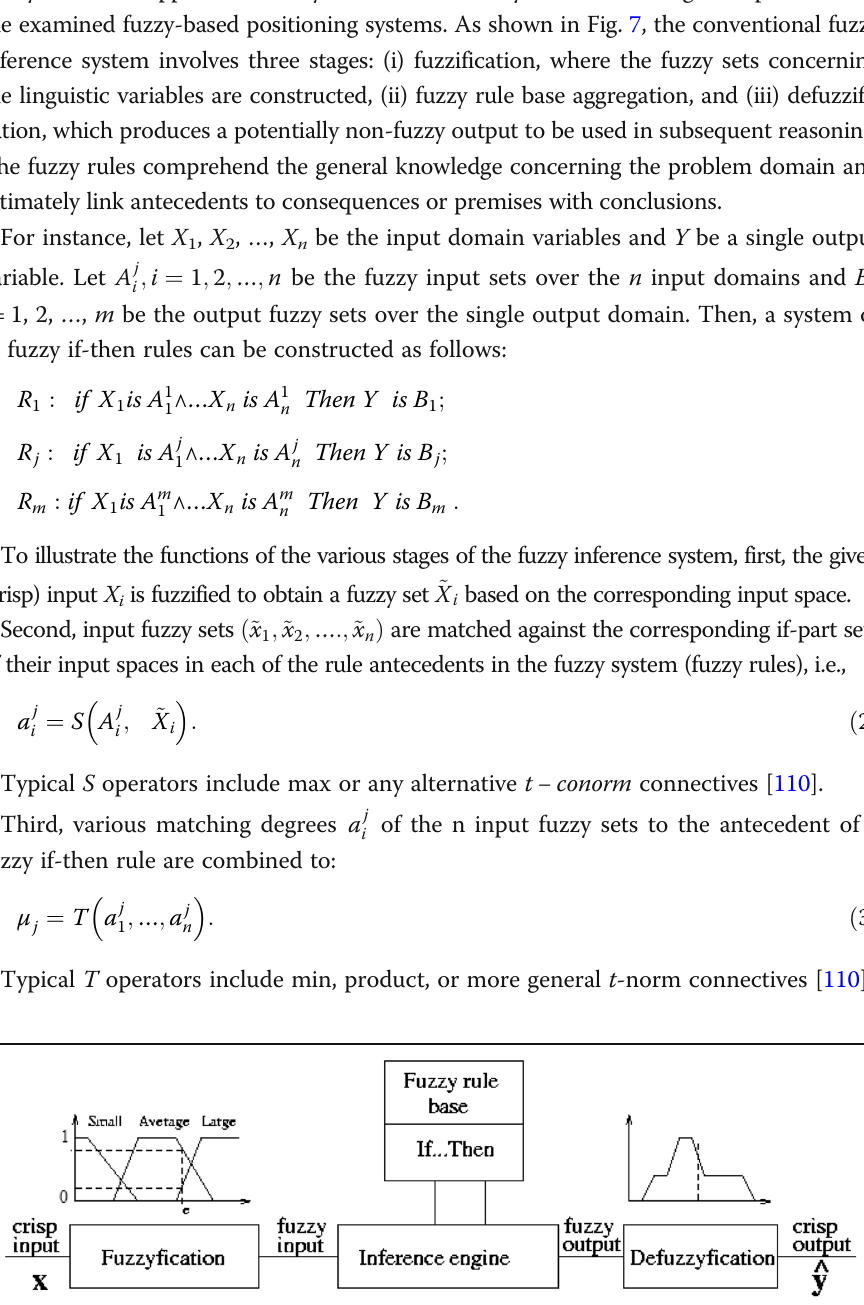
Fig. 7 An example of the fuzzy inference